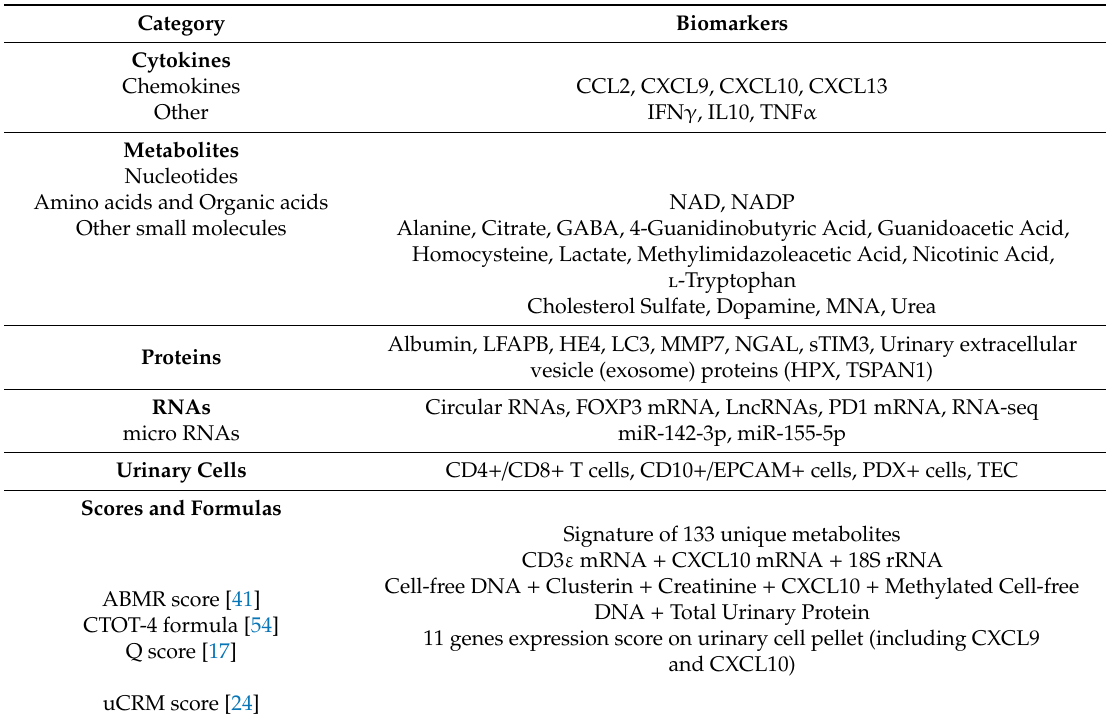
Table 2. Urinary biomarkers. Table illustrating all urinary biomarkers divided per category and in alphabetic order. Specific formulas and scores are also